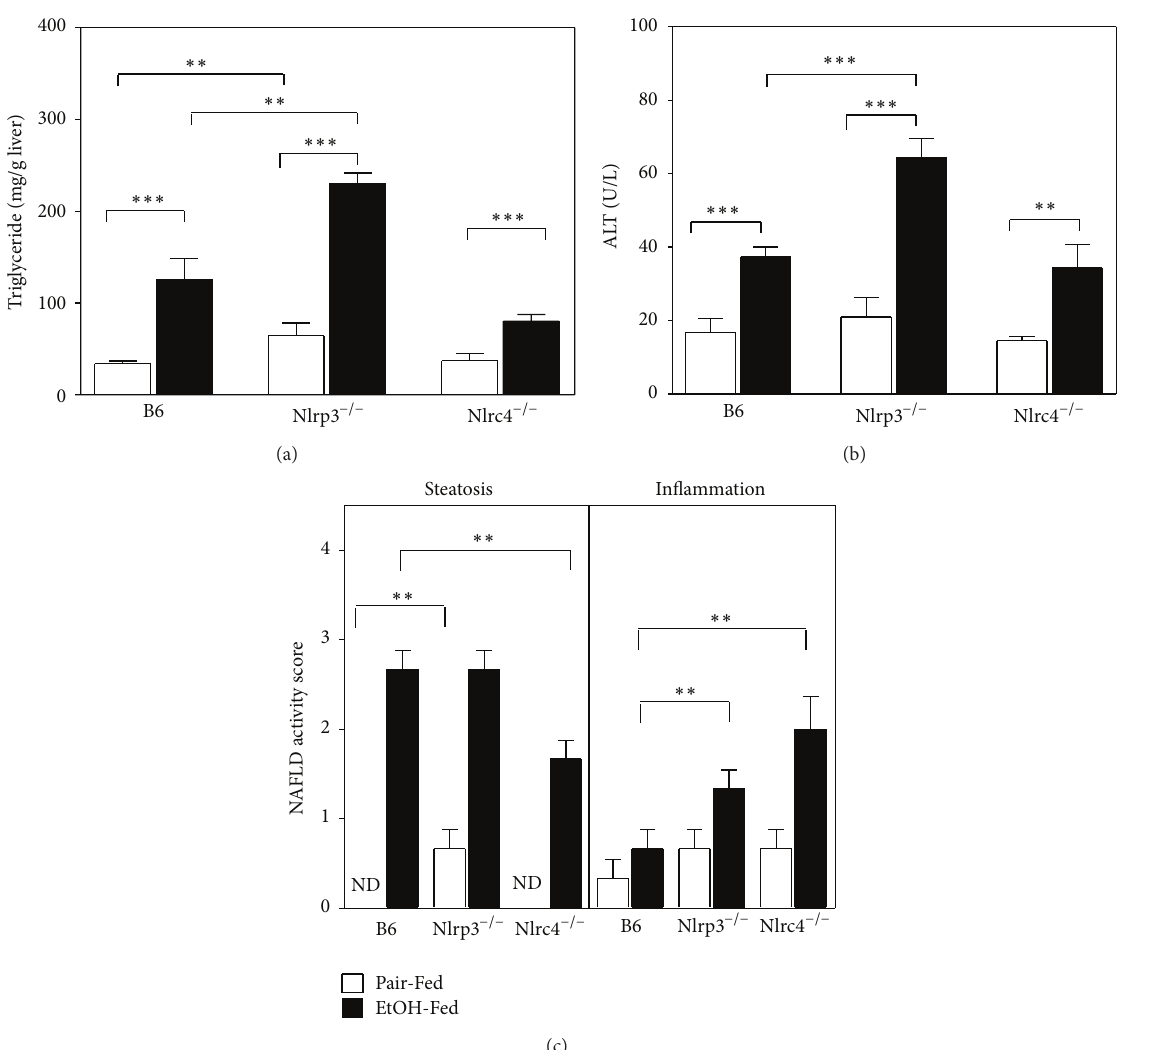
Figure 2: Measurements of liver injury. (a) Hepatic triglycerides were measured biochemically from C57BL/6J (B6), Nlrp 3 −/− , and Nlrc 4 −/−